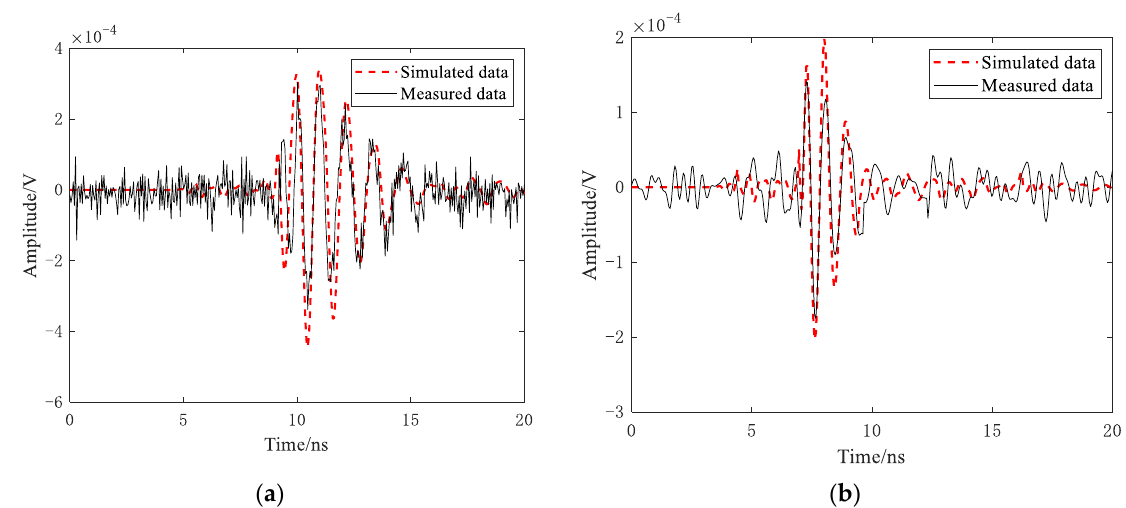
Figure 3. Experiment results: ( a ) triangular reflector and ( b ) conductor sphere.